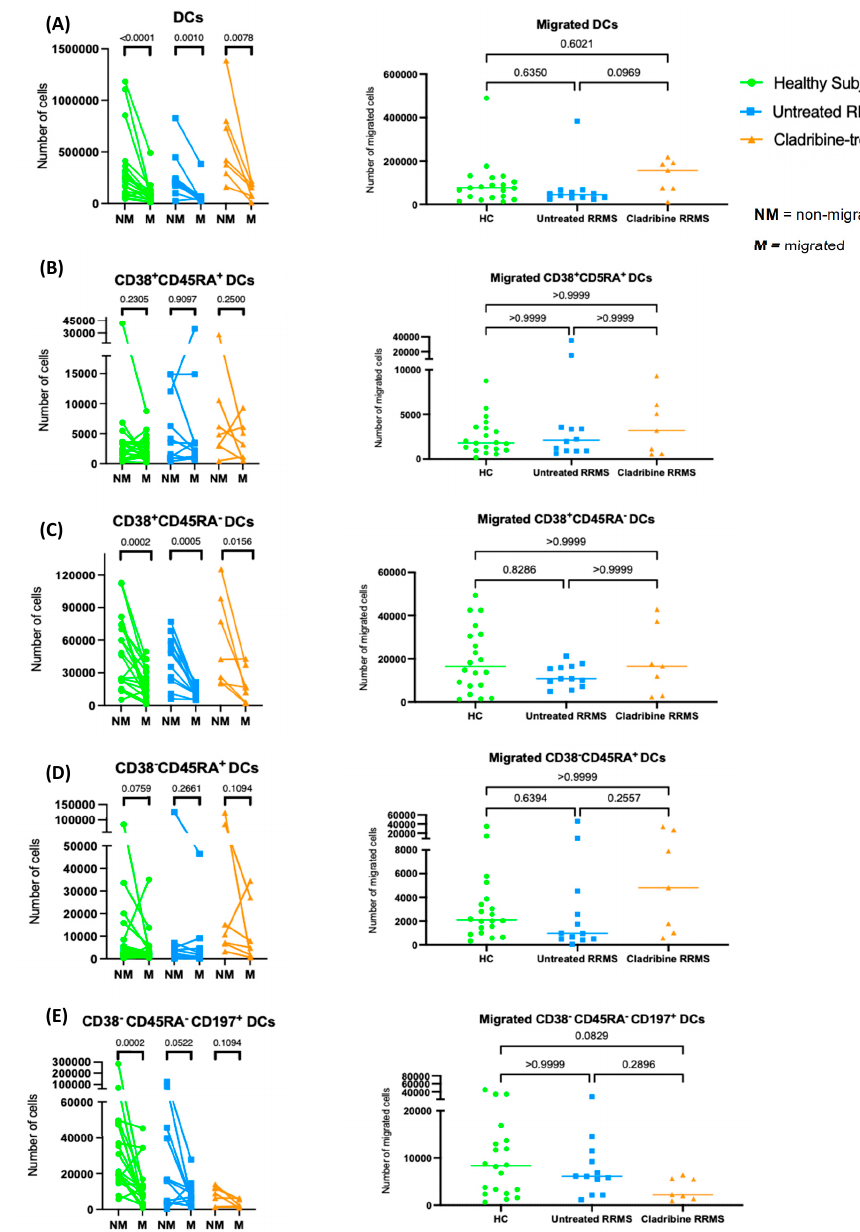
Figure 3. Cladribine does not alter DC transmigration. PBMCs from healthy subjects ( n = 20), untreated RRMS patients ( n = 12) and cladribine-treated RRMS patients ( n = 7) were added to a transmigration assay and left overnight to migrate across the stimulated endothelial layer. ( A ) Absolute numbers of non–migrated (NM) vs. migrated (M) DCs in each group ( left ) and absolute numbers of migrated DCs in each group ( right ). ( B ) Absolute numbers of non–migrated (NM) vs. migrated (M) CD38 + CD45RA + DCs in each group ( left ) and absolute numbers of migrated CD38 + CD45RA + DCs in each group ( right ). ( C ) Absolute numbers of non-migrated (NM) vs. migrated (M) CD38 + CD45RA − DCs in each group ( left ) and absolute numbers of migrated CD38 + CD45RA − DCs in each group ( right ). ( D ) Absolute numbers of non–migrated (NM) vs. migrated (M) CD38 − CD45RA + DCs in each group ( left ) and absolute numbers of migrated CD38 − CD45RA + DCs in each group ( right ). ( E ) Absolute numbers of non–migrated (NM) vs. migrated (M) CD38 − CD45RA − CD197 + DCs in each group ( left ) and absolute numbers of migrated CD38 − CD45RA − CD197 + DCs in each group. Wilcoxon matched–pairs signed–rank test for M vs. NM. Kruskal–Wallis nonparametric one–way ANOVA with Dunn’s multiple comparisons test for migrated cells. The significance was dictated by p <